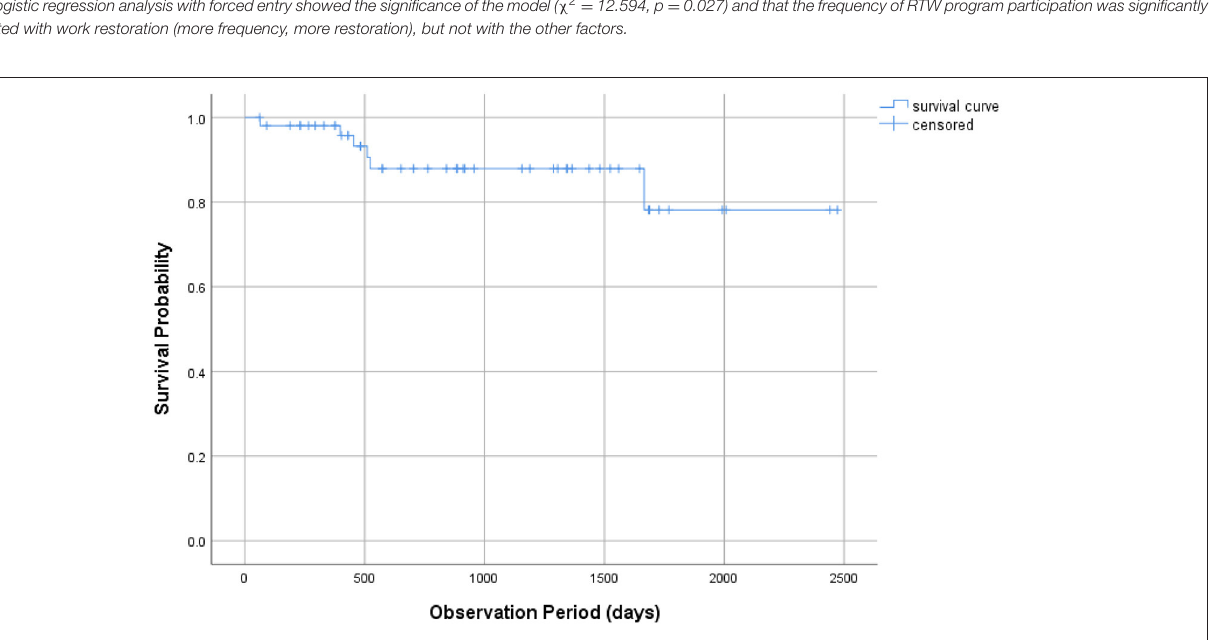
FIGURE 1 | Kaplan–Meier survival